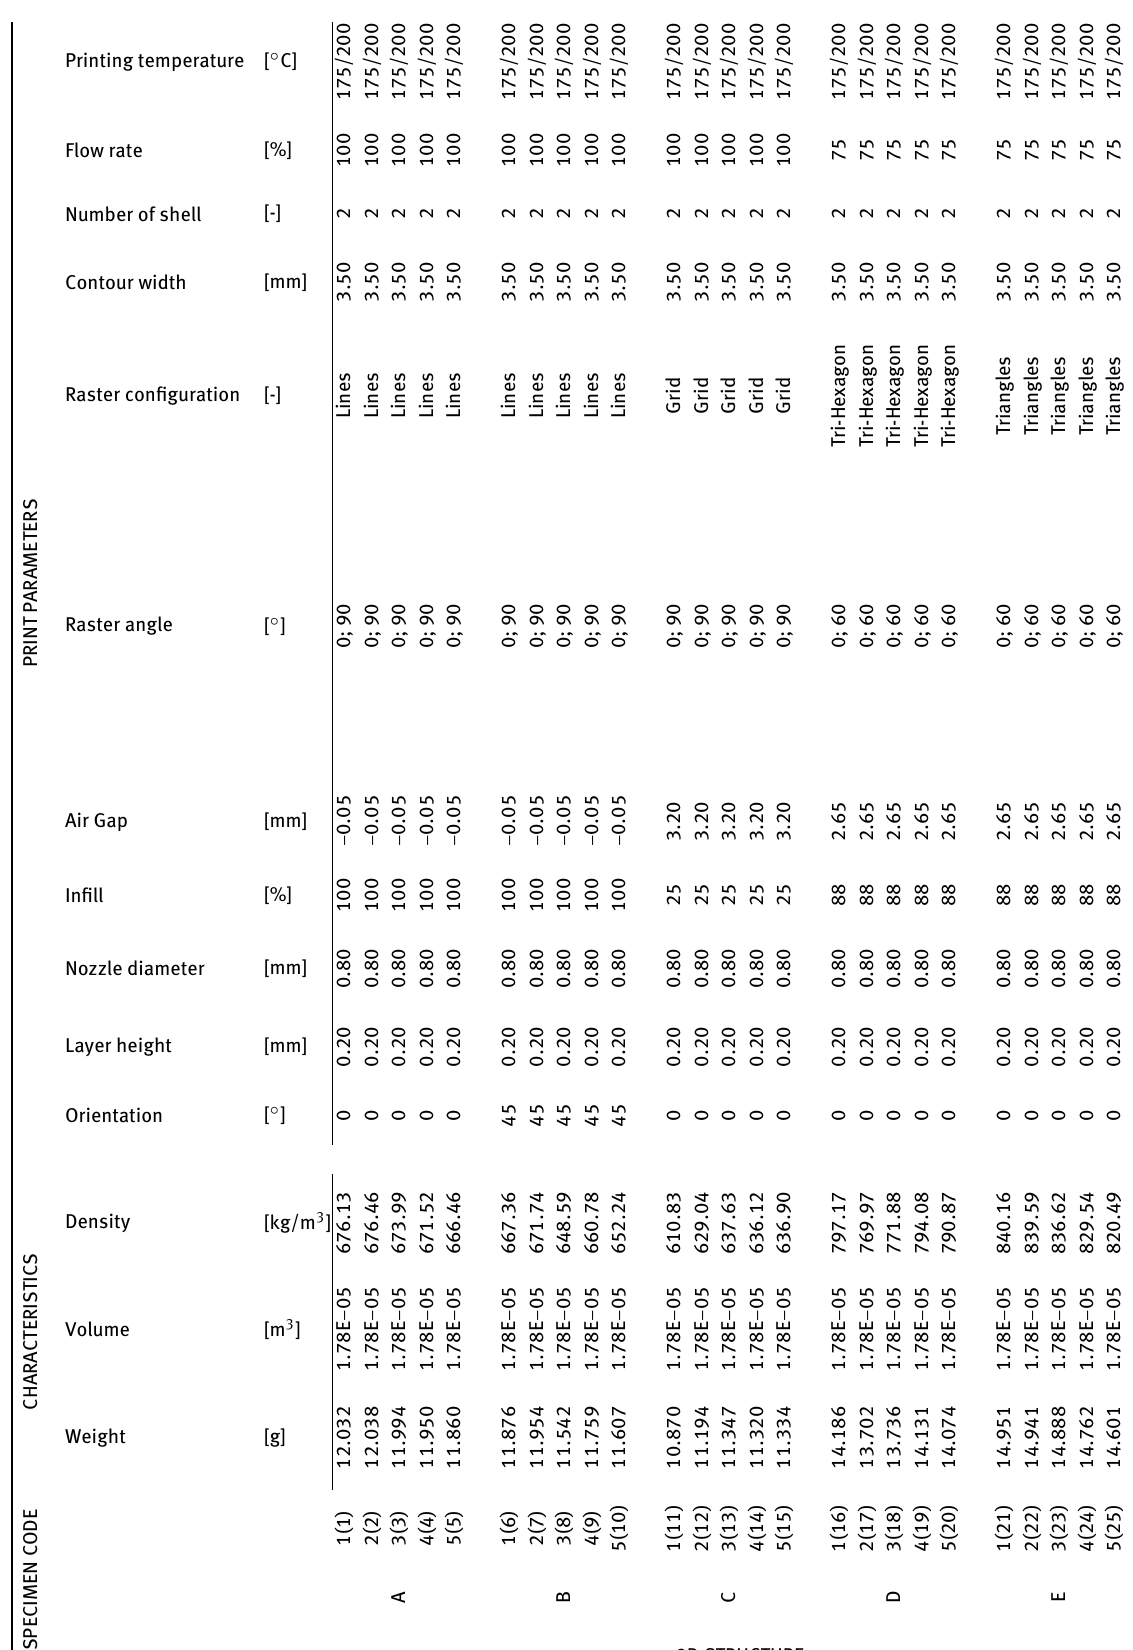
WeightVolumeDensity